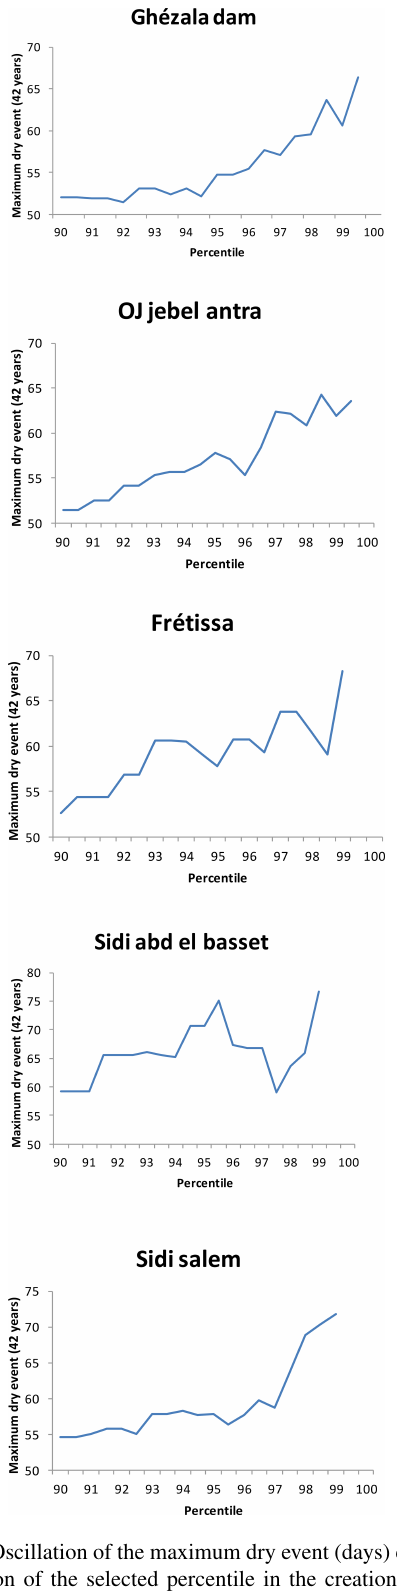
Figure 3. Oscillation of the maximum dry event (days) estimations as a function of the selected percentile in the creation of the dry event PDS. Five representative rain gauges are shown.